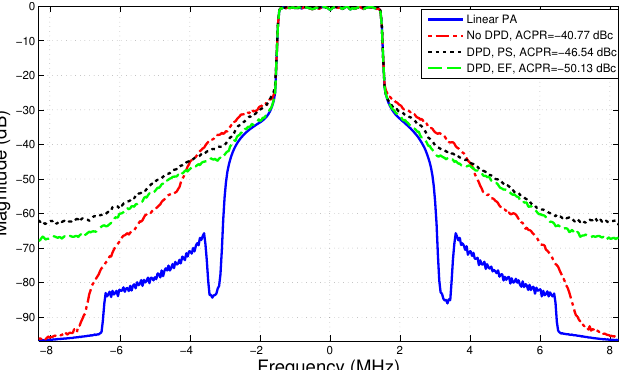
Figure 5. Output spectra of the ideal linear PA, the Wiener PA model without DPD, with DPD under configuration obtained from PS and EF.